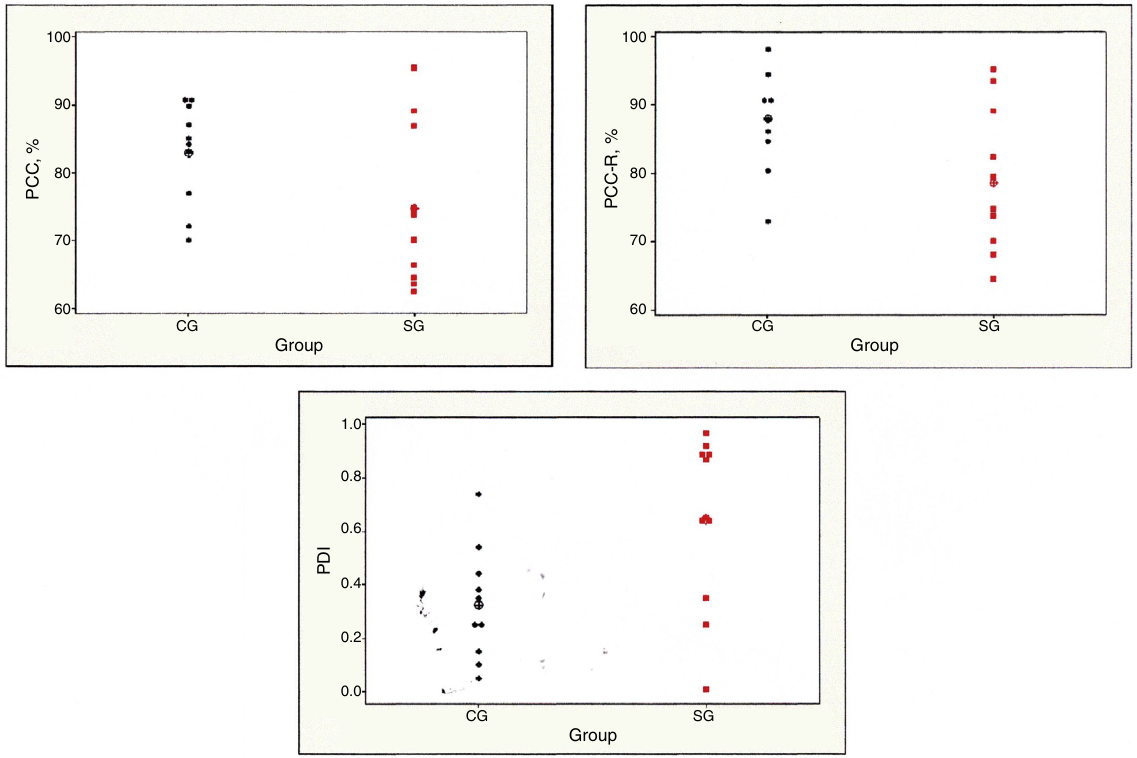
Figure 1 Individual and mean values of Percentage of Consonants Correct (PCC), Percentage of Consonants Correct-Revised (PCC-R), and Process Density Index (PDI) in the control group (CG) and study group (SG).